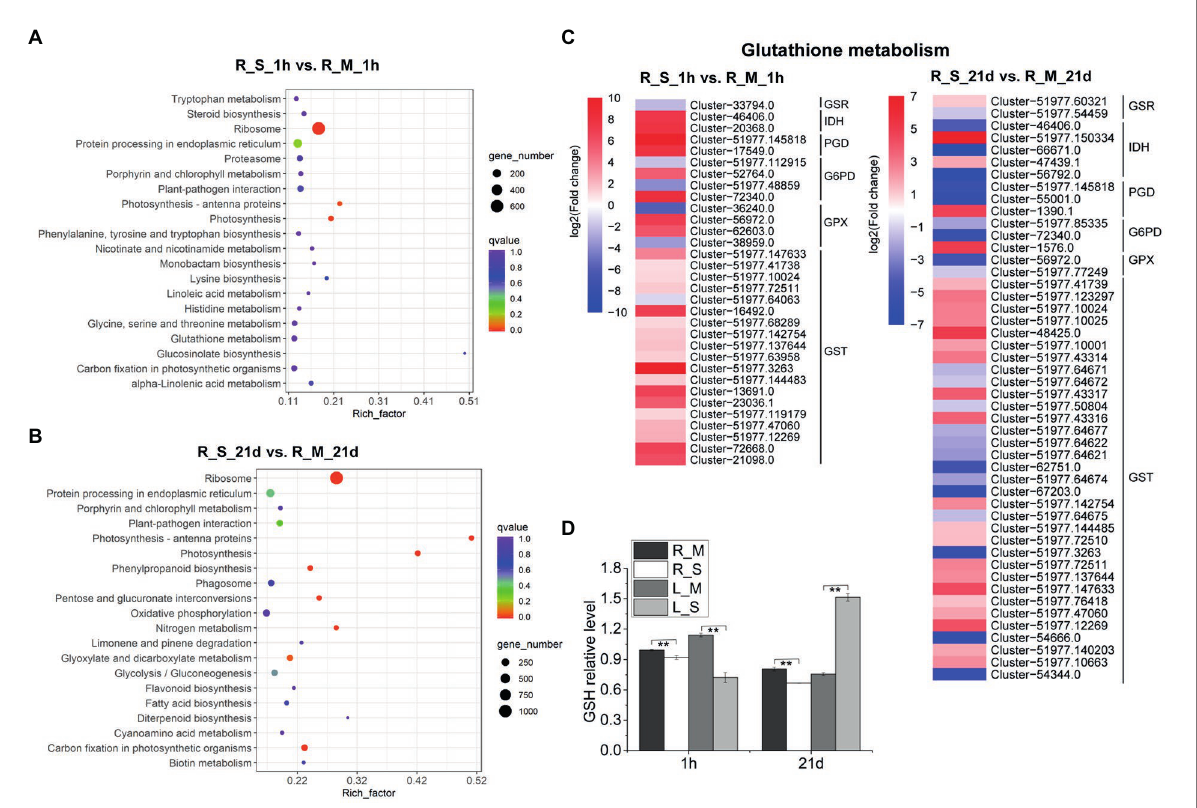
FIGURE 5 KEGG analysis of DEGs in roots and expression analysis of DEGs involved in “glutathione (GSH) metabolism.” (A) The top 20 pathways that were significantly enriched in roots after 1 h of salt treatment (400 mM Na). (B) The top 20 pathways that were significantly enriched in roots after 21 days of salt treatment. (C) Expression analysis of DEGs in roots involved in “Glutathione metabolism” after 1 h and 21 days of salt treatment. (D) The relative content of GSH in roots and leaves compared to the R_M sample. R_M and L_M mean roots and leaves of plants untreated with Na. R_S and L_S mean roots and leaves of plants treated with 400 mM Na. The error bars were calculated from three biological replicates. Mean separation was based on Tukey HSD test at p < 0.01 (**)